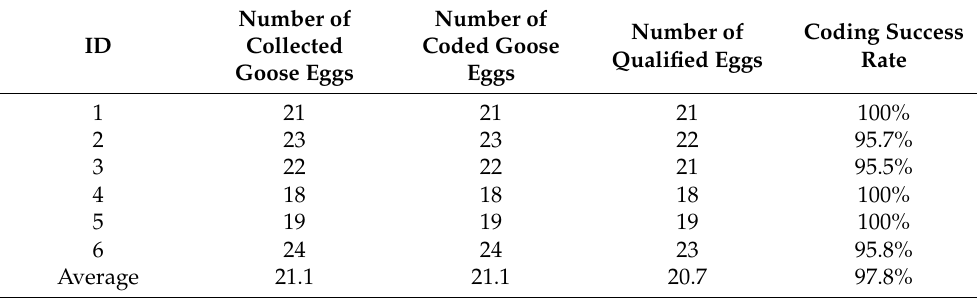
Table 3. The results of goose eggs